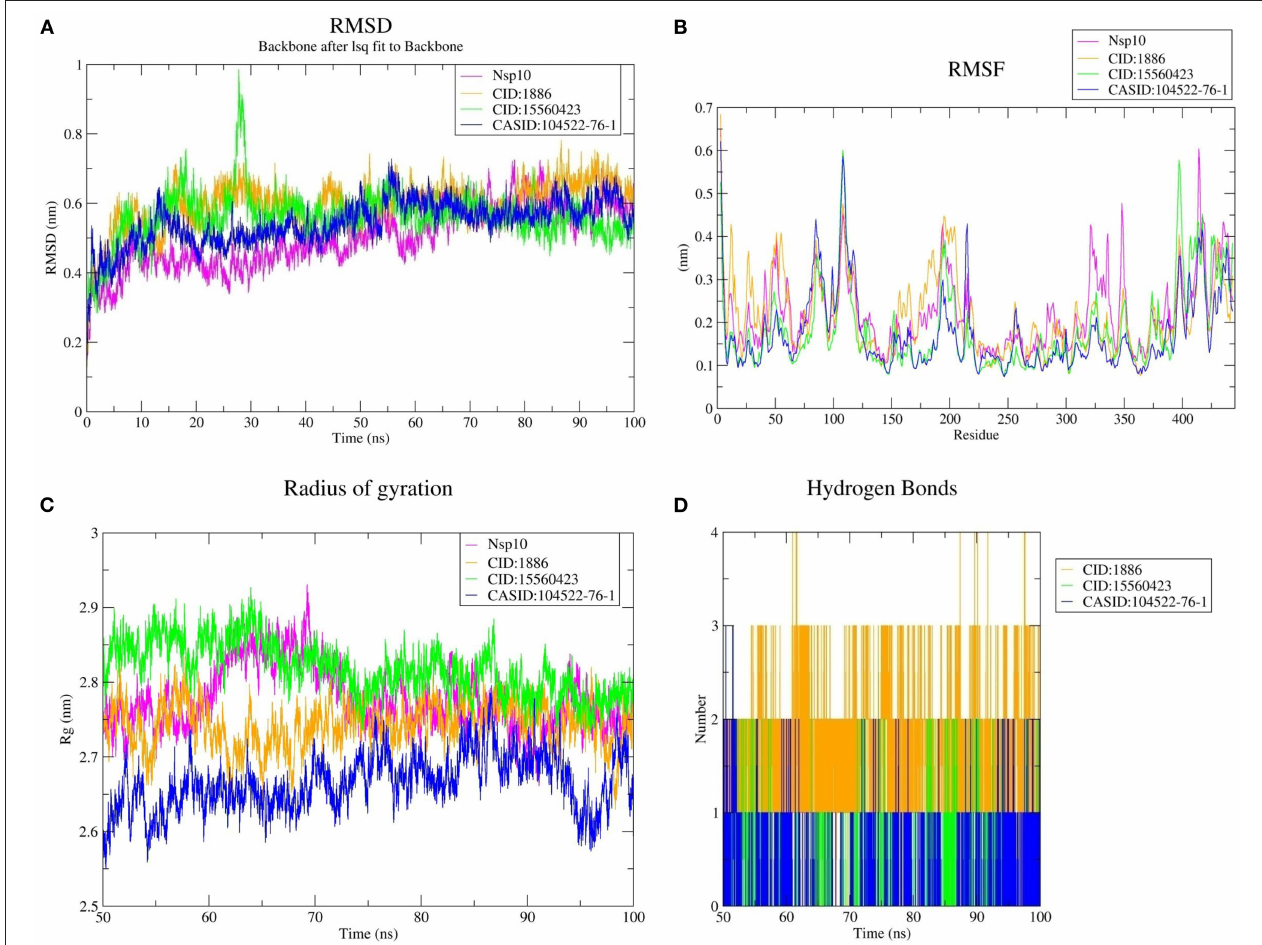
FIGURE 5 | MD simulation results, (A) RMSD plot of Nsp10 and the Nsp10-phytochemical complexes, (B) RMSF, and (C) Rg plots of Nsp4 and the Nsp4-phytochemical complexes over the final 50 ns of the MD simulations. Magenta, orange, green, and blue colors represent Nsp10, Nsp10-CID:1886, Nsp10-CID:15560423, and Nsp10-CASID:104522-76-1, respectively. (D) A plot showing the number of hydrogen bonds formed over the final 50 ns trajectory for each respective complex. Orange, green, and blue colors represent Nsp10-CID:1886, Nsp10-CID:15560423, and Nsp10-CASID:104522-76-1, respectively.